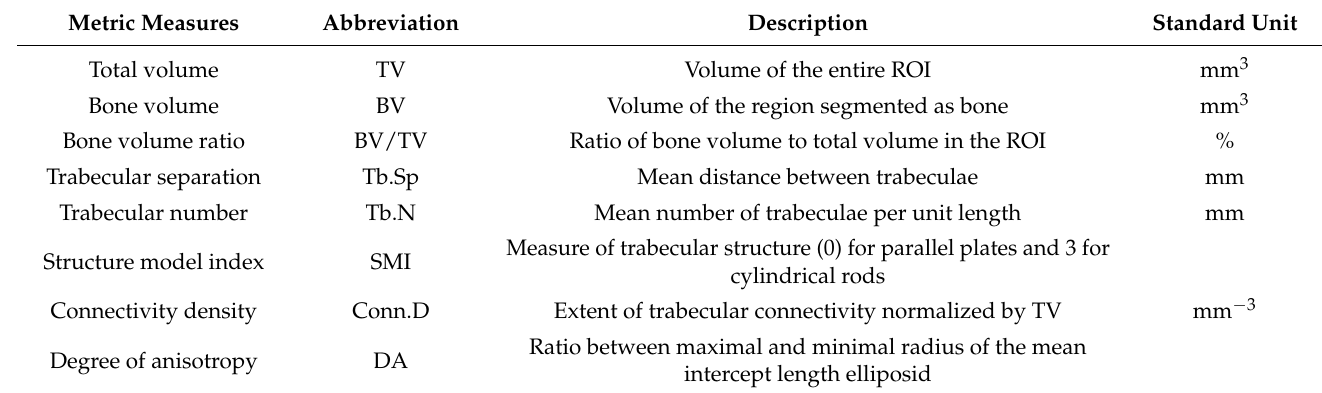
Table 2. pQCT parameters with associated abbreviations, description, and unit.